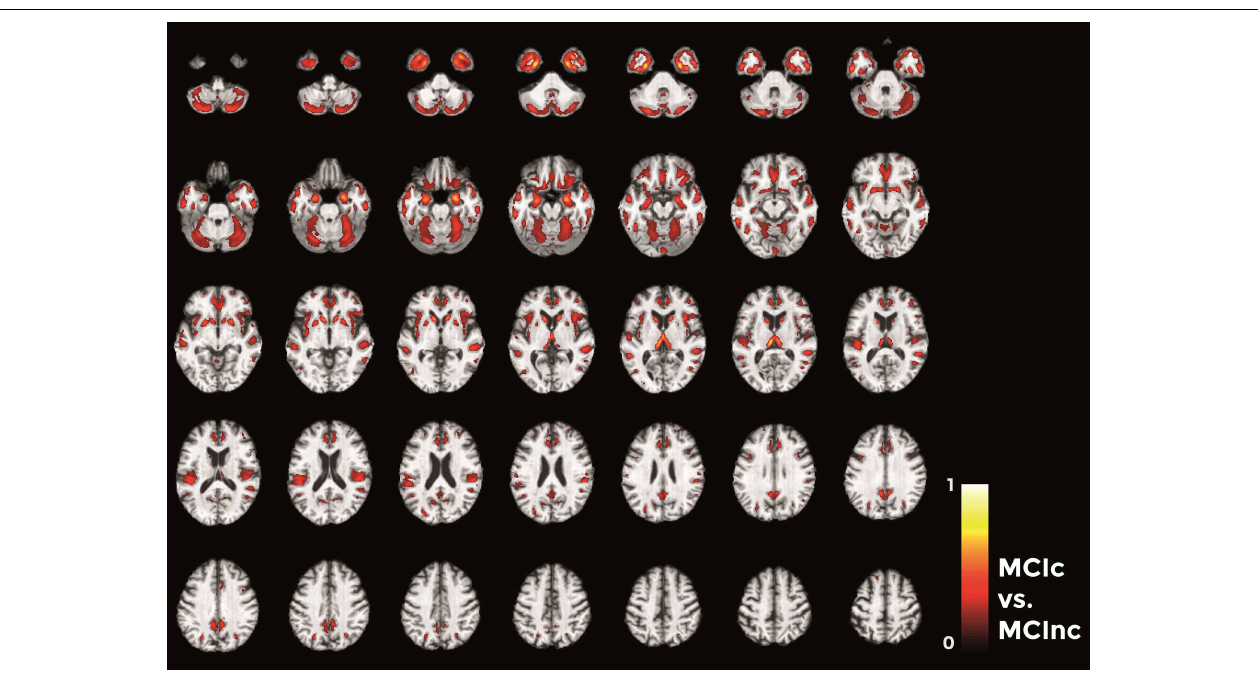
FIGURE 12 | Voxel-based pattern distribution map (axial view) for the classification between MCIc and MCInc. Voxel-based pattern distribution (normalized to a range between 0 and 1) is expressed according to the color scale (threshold = 35%) and superimposed on a standard stereotactic brain for spatial localization.